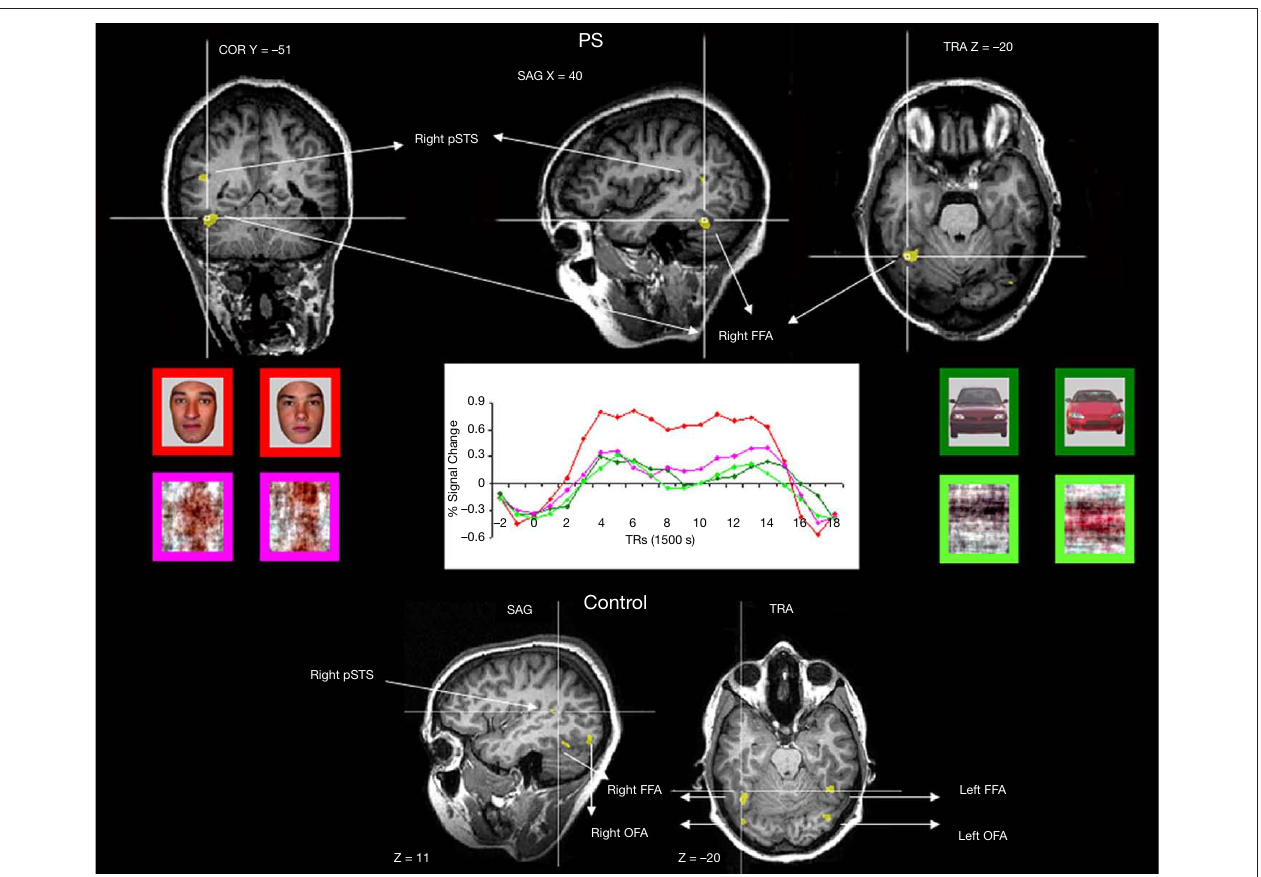
Figure 2 | Functional brain areas disclosed in the face localizer experiment with faces, scrambled faces, pictures of cars and scrambled cars. The different areas (bilateral FFA, OFA, and right pSTS) are displayed below for a normal participant, and the intact part of this network is illustrated for the patient PS on top (right FFA, left OFA, right pSTS). Note the asymmetrical lesions, damaging the cortical territory of the right OFA and left FFA (for a full description, see Sorger et al.,